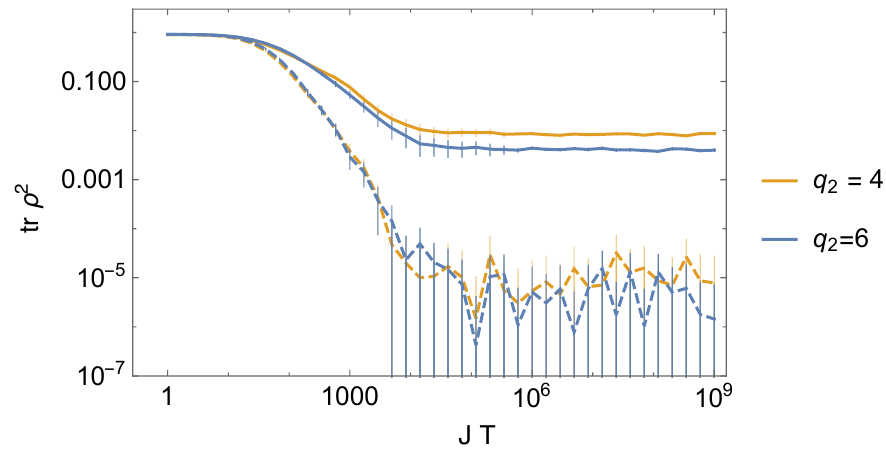
Figure 3 . N = 20 , n trials = 1000 , βJ = 16 , (cid:15) = 0 . 1 . We show q 2 = 4 , 6 deformations and 1 σ error bars. Note that q 2 = 6 is an irrelevant deformation, but the curves seem qualitatively similar to the marginal